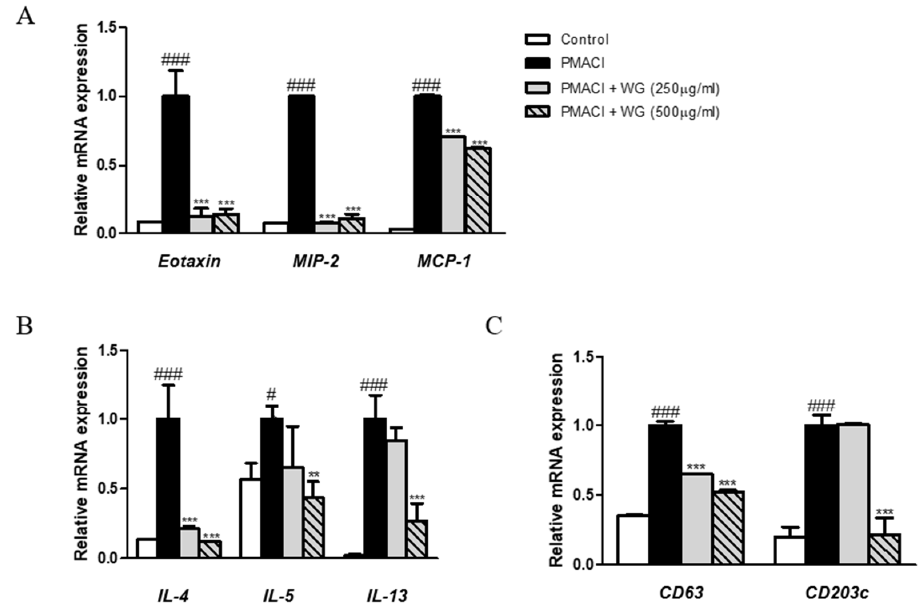
Figure 5. Effects of WG on the chemokine, CD antigens, and Th2 cytokines in PMACI-stimulated HMC-1 cells. Total RNA prepared from HMC-1 cells, while the mRNA levels of ( A ) Eotaxin, MIP-2, MCP-1, ( B ) CD63, CD203c, and ( C ) IL-4, IL-5, IL-13 were determined by quantitative qRT-PCR. The data shown represent means ± S.D. of three independent experiments. Note: # p < 0.05, ### p < 0.001 vs. the control group; ** p < 0.01, *** p < 0.001 vs. PMACI-treated group.